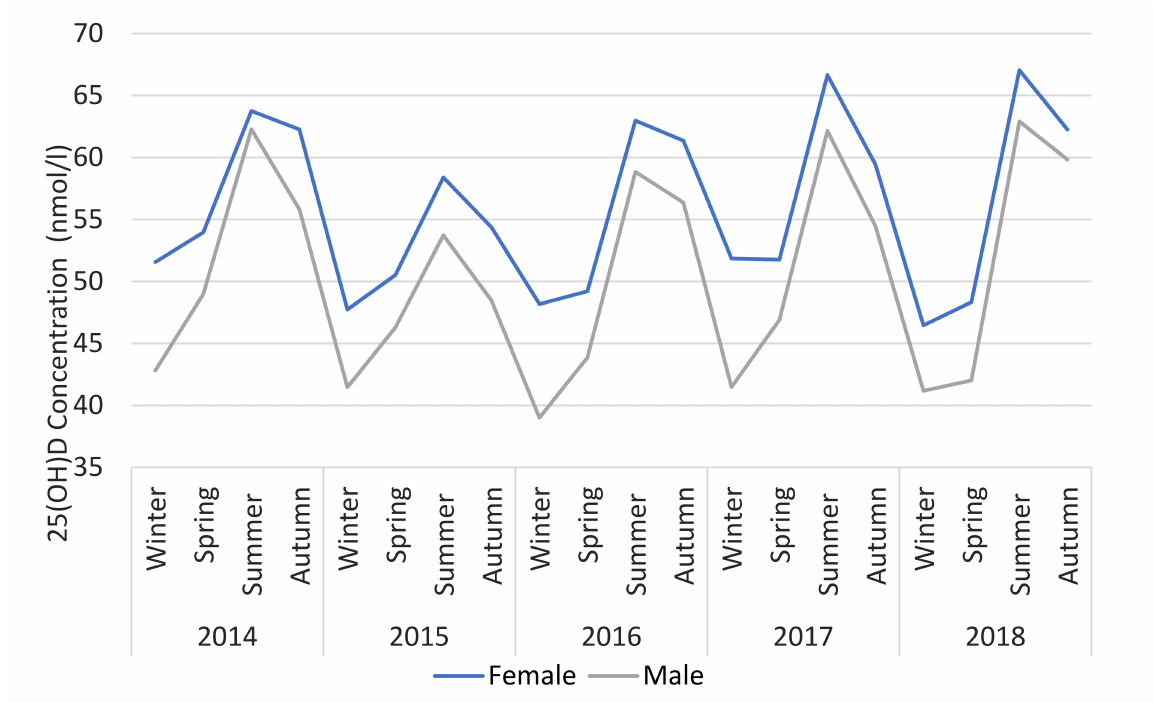
Figure 6. 25(OH)D status versus season, dichotomised by gender.